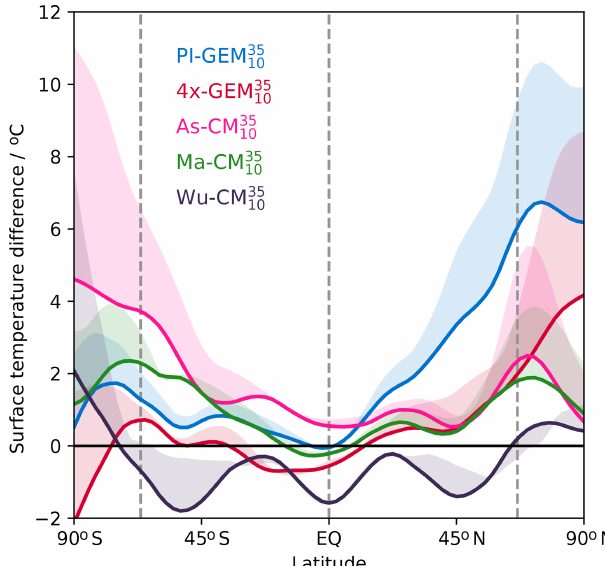
Figure 5. Zonally and annually averaged surface air temperature difference (solid lines) from 10% to 35% oxygen content for PI- GEM (blue), 4 × PI-GEM (red), As-CM (pink), Ma-CM (green) and Wu-CM (purple). The difference from the annual mean to cold- month mean for each run is indicated by the shading. Values are smoothed by a Savitzky–Golay filter (Savitzky and Golay, 1964). Figure 6. Annually averaged total precipitation change from 10%